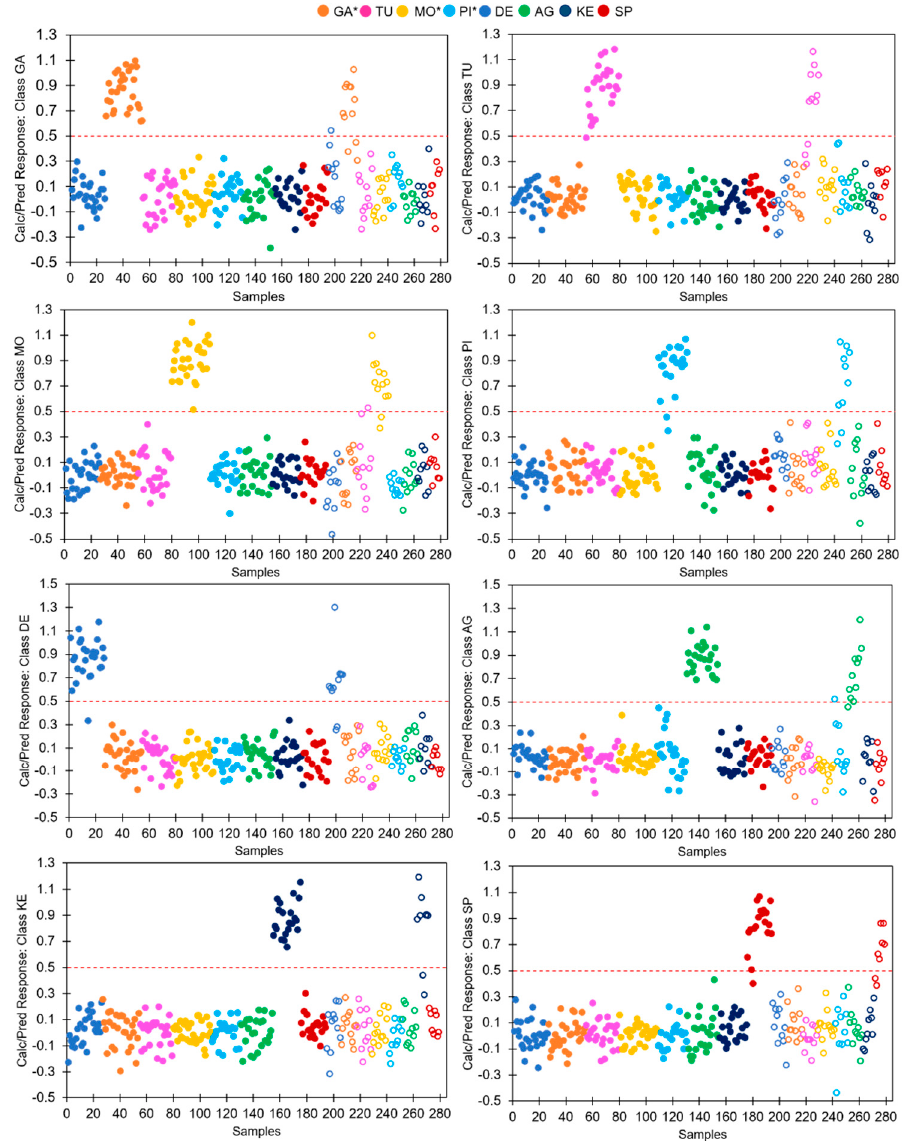
Figure 6. Calculated / predicted PLS-DA responses versus sample index. The open circles identify the external data samples and the red dotted line indicates the class threshold. Asterisks indicate the accessions from Majella National Park.